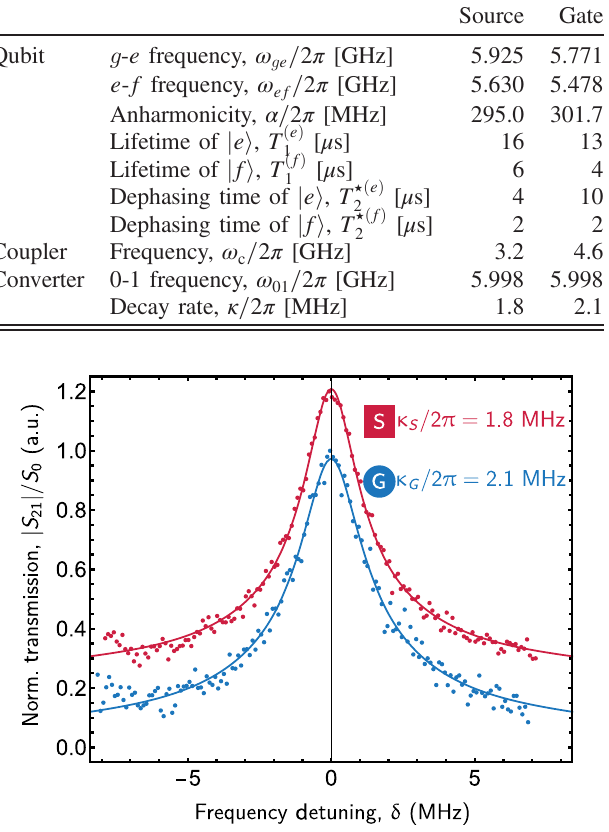
FIG. 7. Absolute value of the measured transmission coefficient j S j =S 21 0 , normalized to the transmission at zero detuning S 0 , when driving the converter mode of the gate qubit (blue) and the source qubit (red, vertically offset by 0.2) via their respective charge lines. Solid lines are Lorentzian fits to the data (see the text), resulting in the indicated linewidths κ .